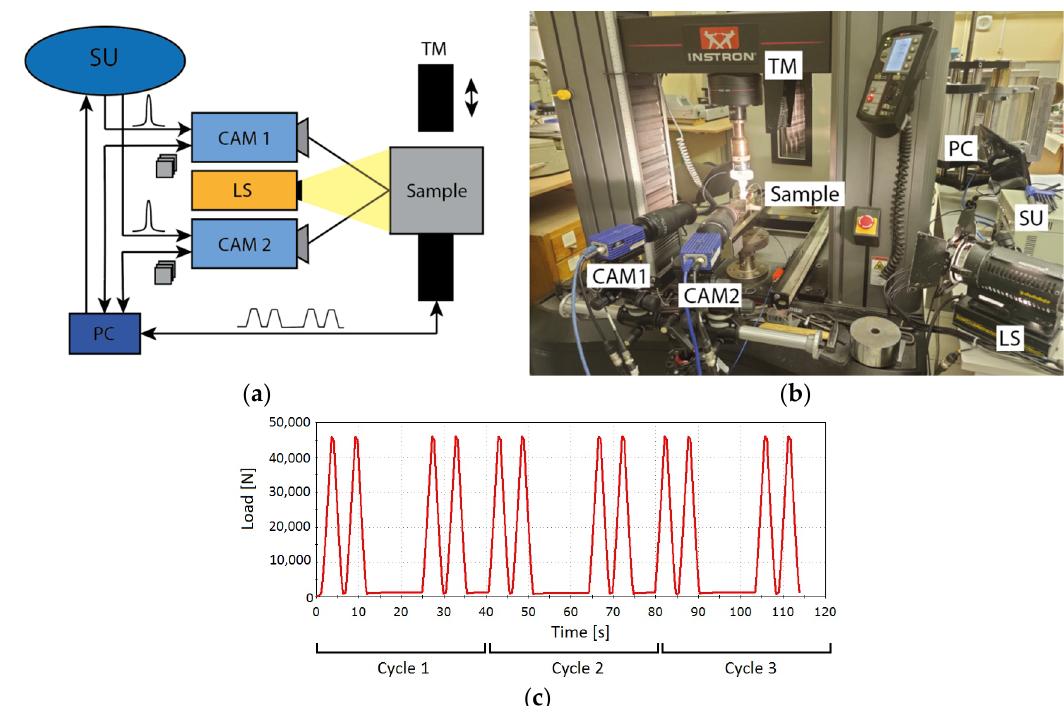
Figure 3. Scheme ( a ) and appearance ( b ) of the experimental setup, and loading cycles ( c ) .